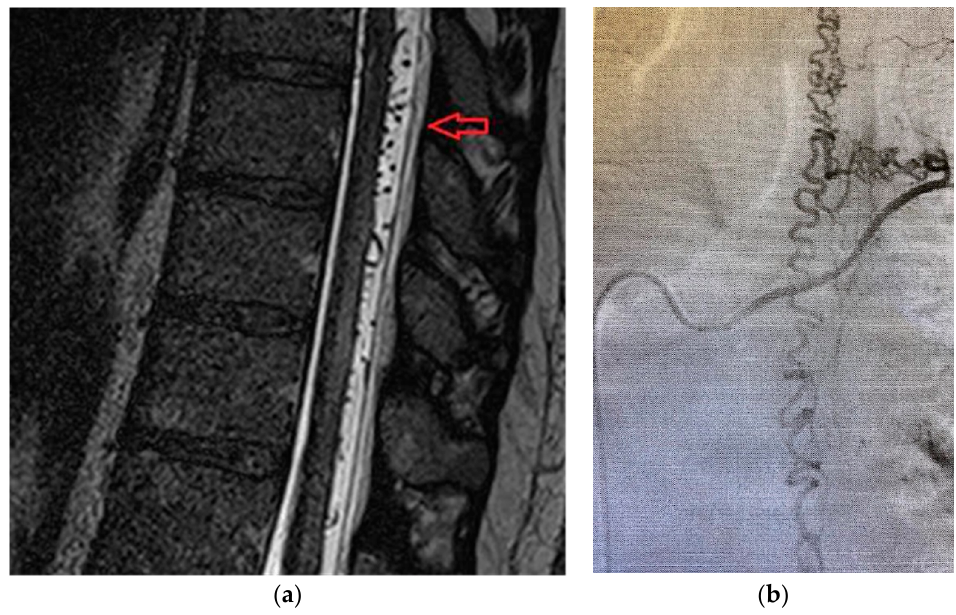
Figure 5. ( a ) Fast ‐ spin ‐ echo ‐ T2 ‐ weighted image shows hyperintense cord from T6 to T10 and serpentine flow voids, consistent with enlarged intradural vessels, posterior to the cord from T6 to T10. ( b ) Digital subtraction angiogram (anteroposterior view) following injection of the right T6 posterior intercostal artery demonstrates a fistula in the region of the right neural foramen with drainage into the canal via the medullary vein.